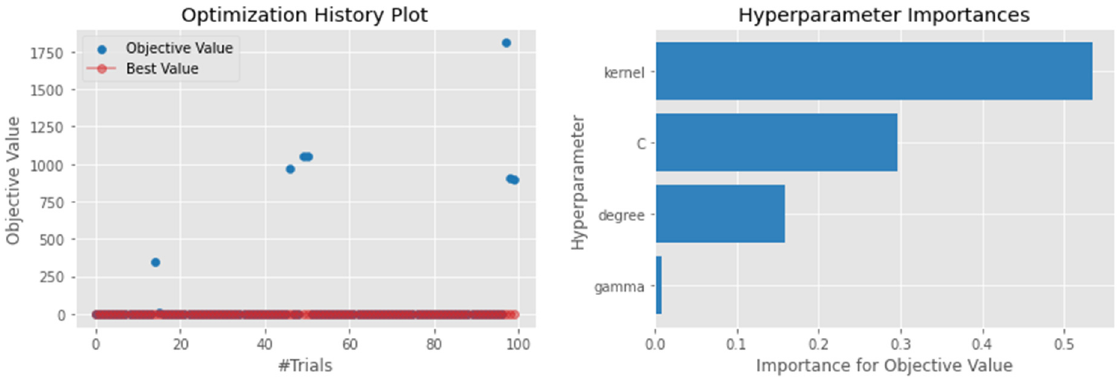
Figure 2. Hyperparameter optimization for the SVR model.